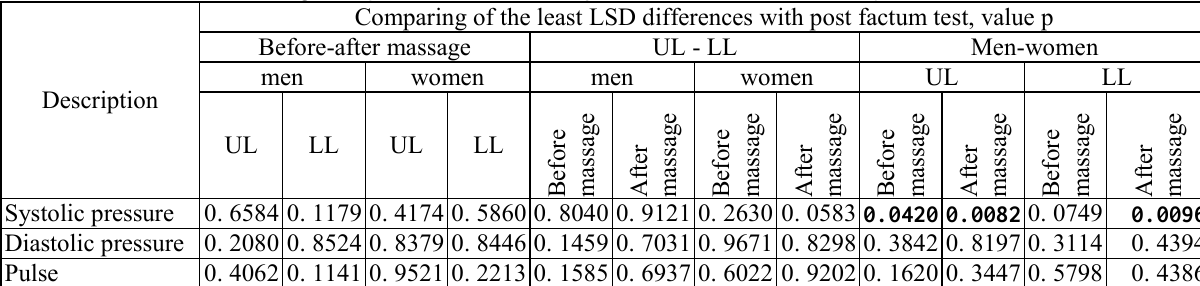
Arithmetic mean and degree of probability for tests LSD (post factum test of the least significant differences) before and after massage are presented in table 1 by factors: sex x, limb x, multiplication factor